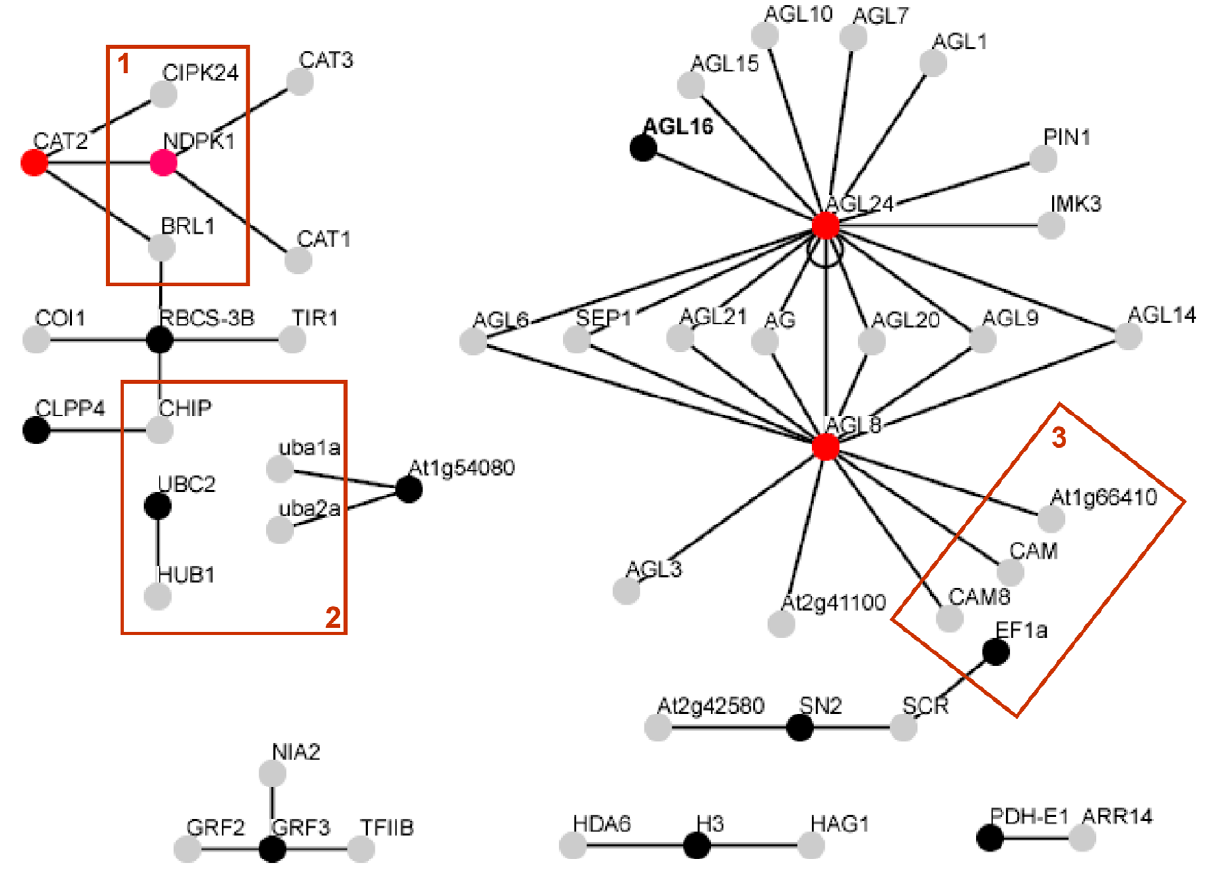
Figure 3. Networks of interacting proteins. Proteins encoded by differentially expressed genes from the microarray experiments and their interacting partners are labelled with black and grey circles, respectively. Proteins which are present on both the microarray and the partner lists (Table S5) are labelled by red circles. Proteins with similar functions are boxed: 1, kinases; 2, ubiquination; 3, calmodulins/calmodulin binding. AGL16, a guard cell-specific transcription factor interacting with AGL24, an Agamous-like transcription factor, is in boldface (see text for explanation). AGL24 interacts with itself too, indicated with a circled line. For protein descriptions and available Solanaceae protein names see Table S5.